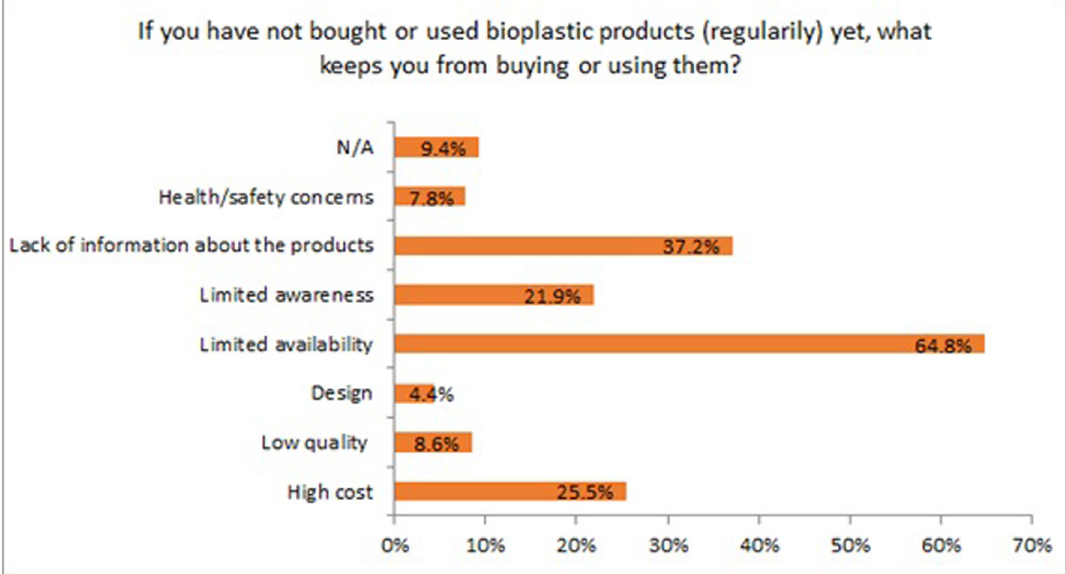
Fig 4. Main obstacles to buying or using bioplastic products regularly (n = 384).